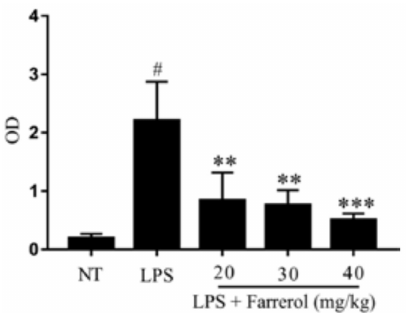
Figure 3. Effects of farrerol on the myeloperoxidase (MPO) activity in mammary gland. The values were presented as the means ± SEM of three independent experiments ( n = 3). # p < 0.05 vs. NT group; * * p < 0.01 and *** p < 0.001 vs. LPS